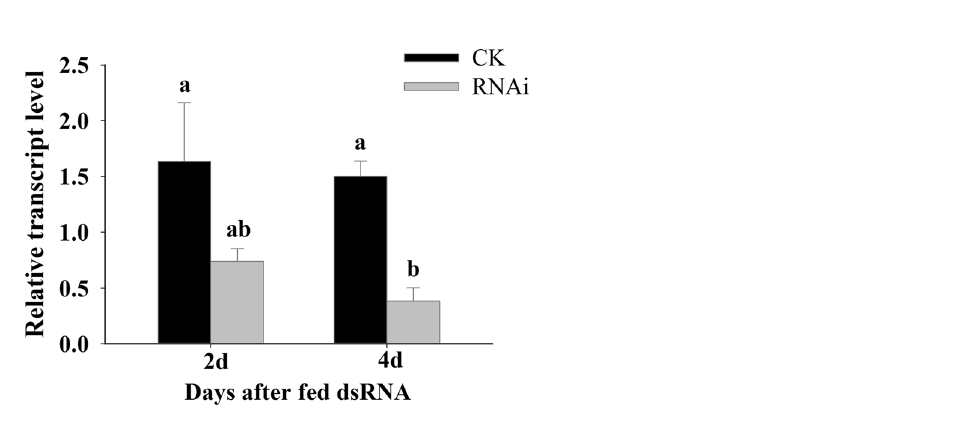
5 Scientific RepoRts | 7: 3623 | DOI:10.1038/s41598-017-03765-y